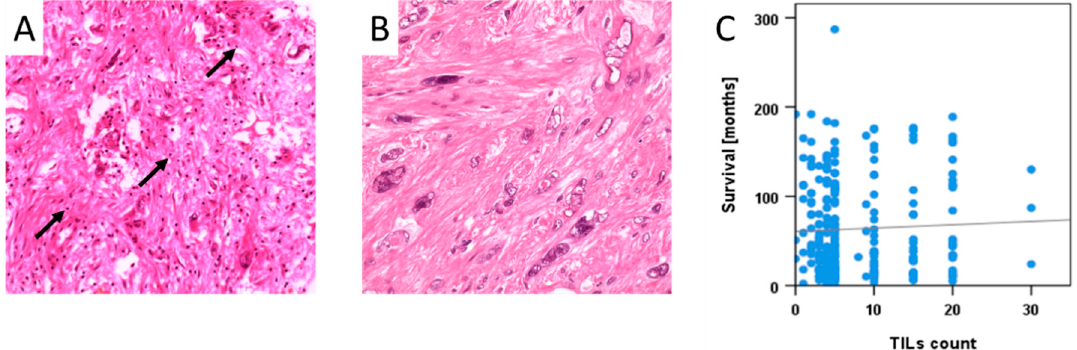
Figure 2. ( A ) and ( B ): representative samples of UPS ( A ) with >4/HPF tumour-infiltrating lymphocytes (TILs) (“positive”) and ( B ) without TILs ( ≤ 3/HPF, “negative”). Pictures are representative micrographs of cores on an H&E stained tissue microarray. Black arrows pointed at TILs. Magnification 20×. ( C ): Relationship between counts of tumour-infiltrating lymphocytes (TILs) and survival. No significant correlation was found (R 2 = 0.0002; p > 0.05).